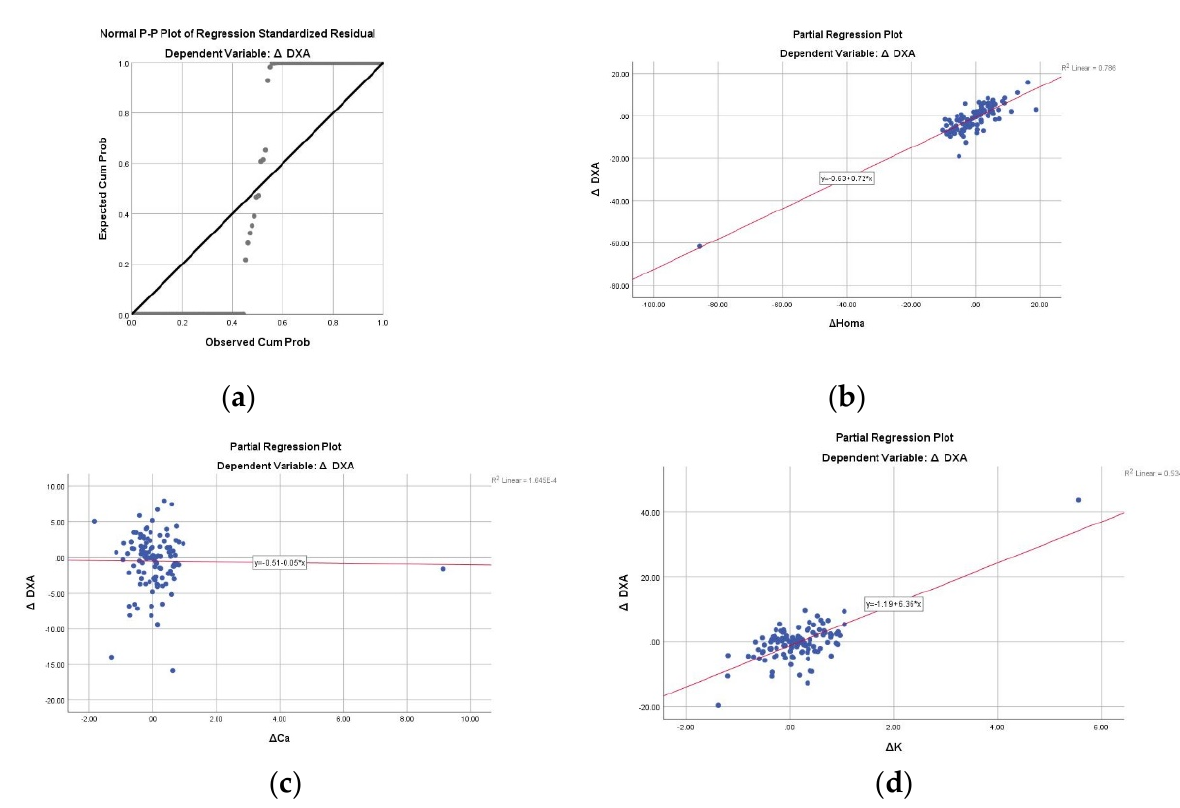
Data were controlled for all covariates displayed at baseline (including length of hospitalisation). Lower insulin resistance but higher calcium and potassium levels were associated with greater weight loss. Figure 1 shows that insulin resistance had the strongest association with weight loss.